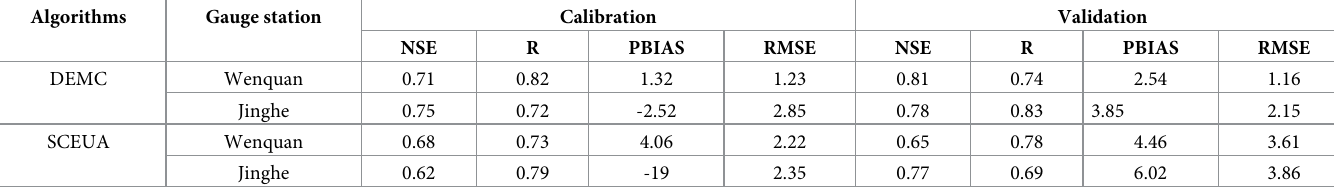
Table 2. Performance evaluation of the VIC